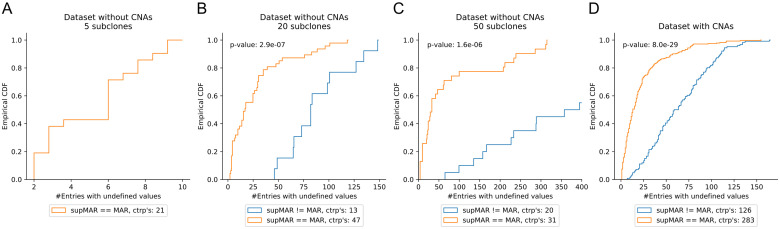
Empirical cumulative density functions (CDFs) of subMARs equaling and differing the MAR for (A)–(C) dataset without CNAs and (A) 5, (B) 20 and (C) 50 subclones, and (D) dataset with CNAs and 20 subclones.Not included are subMARs that do not contain any undefined ancestral relationships (and thus have found the single clone tree solution and equal the MAR), and those for which the DFS did not finish. The p-values are computed with a Kolmogorov-Smirnov test. (C) The empirical CDF for subMARs differing the MAR reaches the value of 1.0 at 864 undefined relationships. ctrp’s: clone tree reconstruction problems.